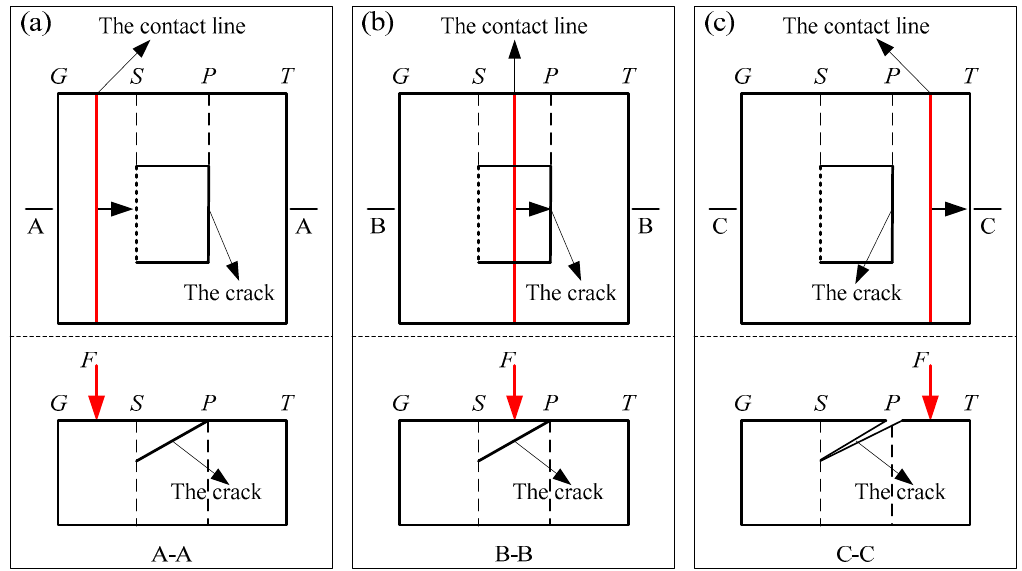
Figure 3. Meshing positions of gear tooth with surface crack fault: ( a ) left of the fault zone, ( b ) above the fault zone, ( c ) right of the fault zone.